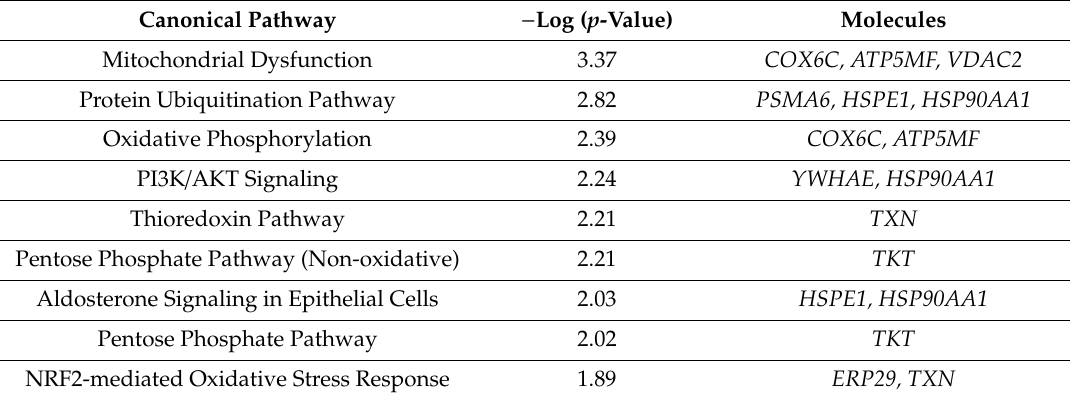
Pentose Phosphate Pathway (Non-oxidative)